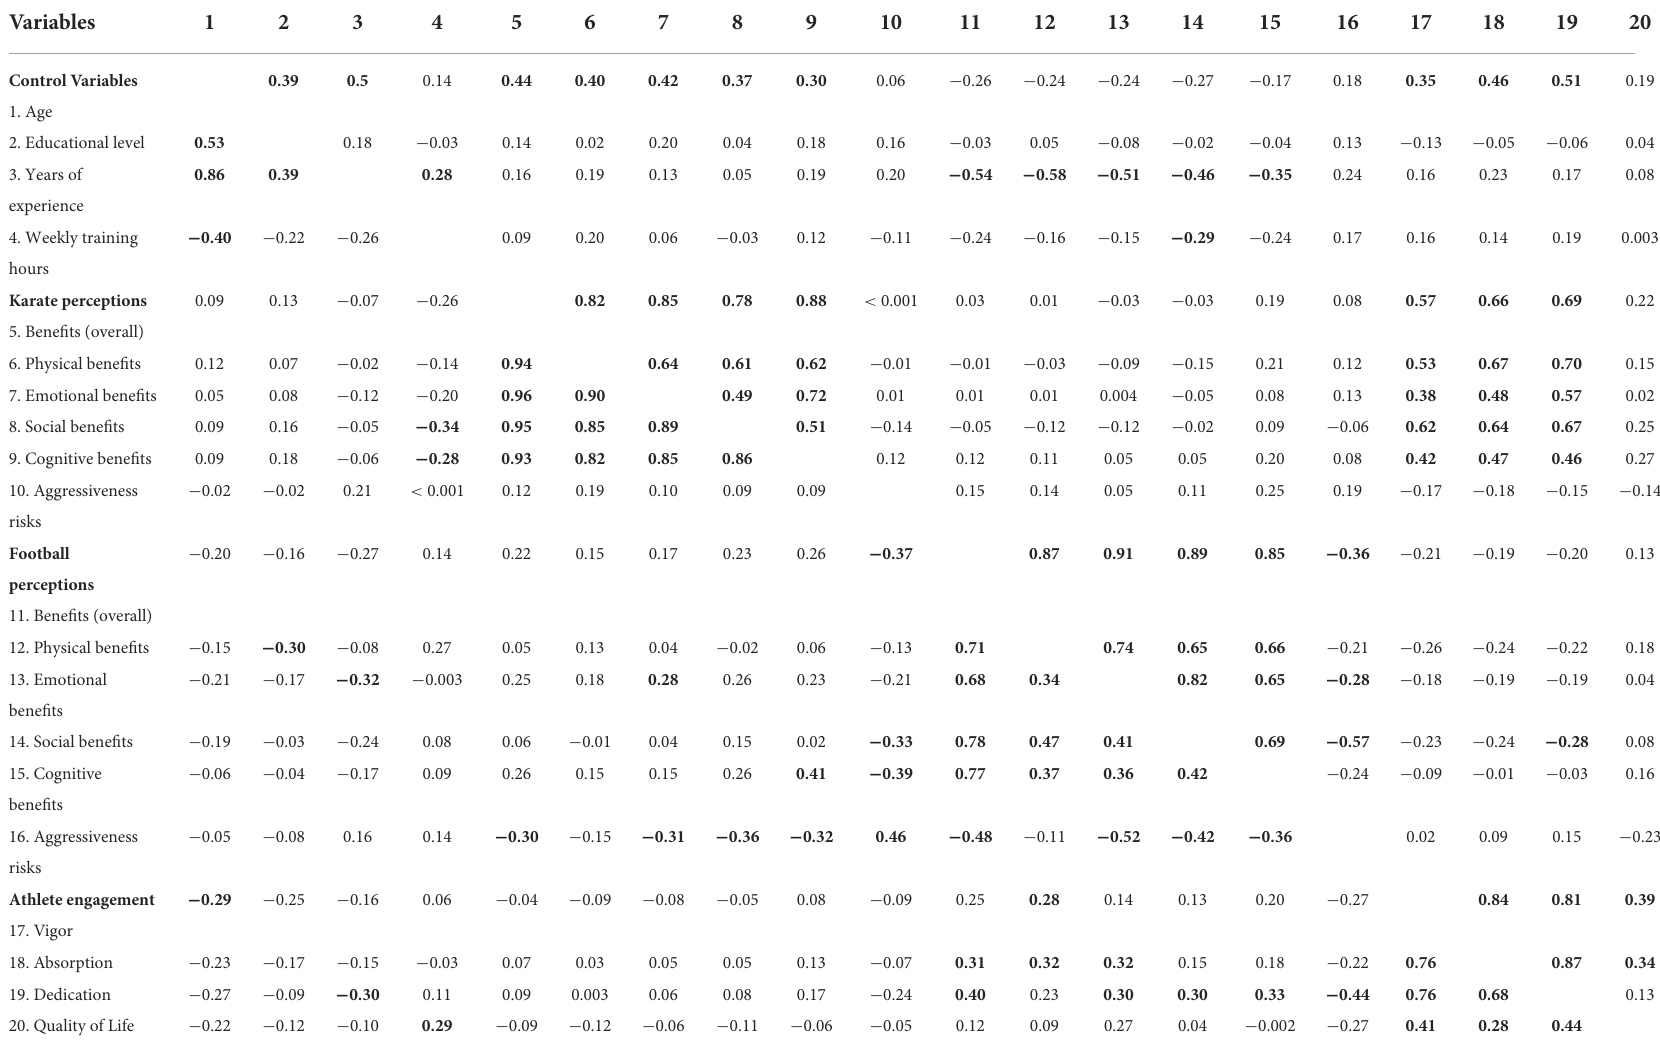
TABLE 3 Bivariate correlations for karate athletes (above the diagonal) and football athletes (below the